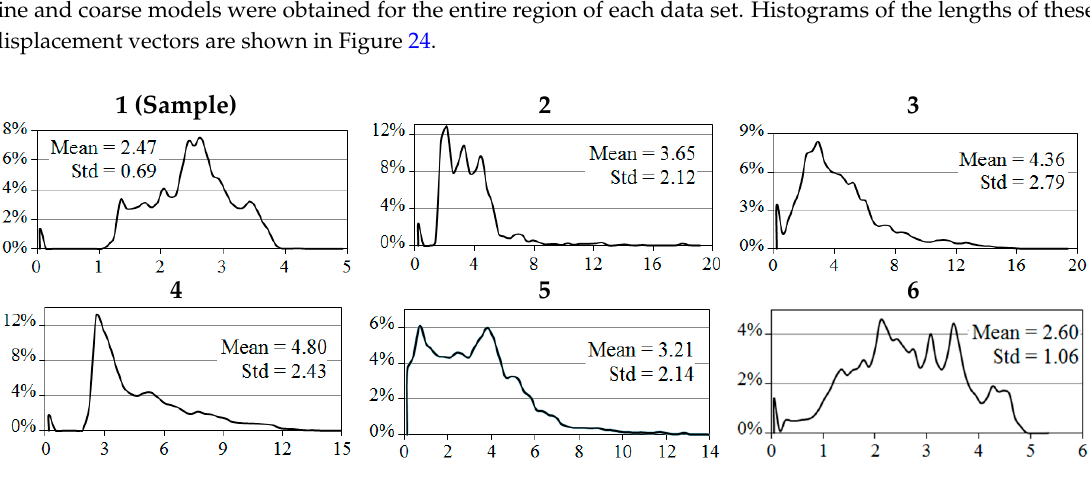
Figure 24. Histograms of the lengths of the displacement vectors between the coarse and fine 3D models for all of the data sets.